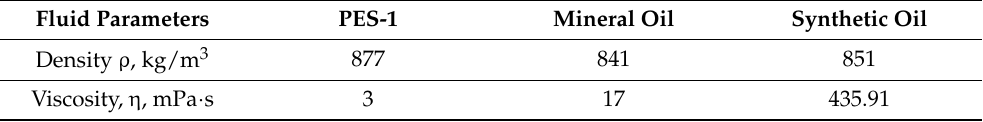
Table 1. Physical properties of the studied fluids.